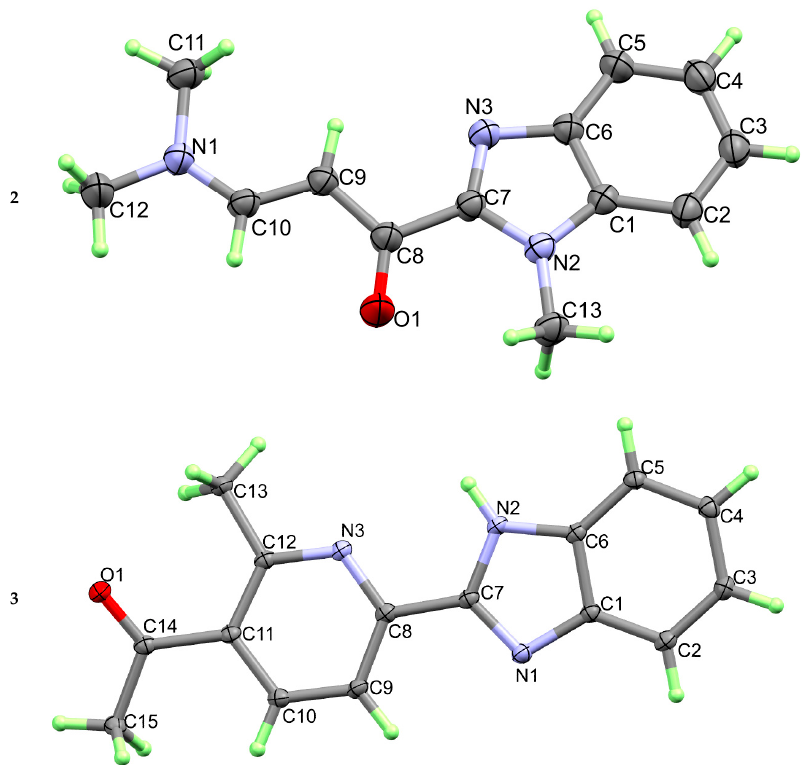
Figure 1. X-ray structure of 2 and 3 . Thermal ellipsoids were plotted at a 30% probability level.